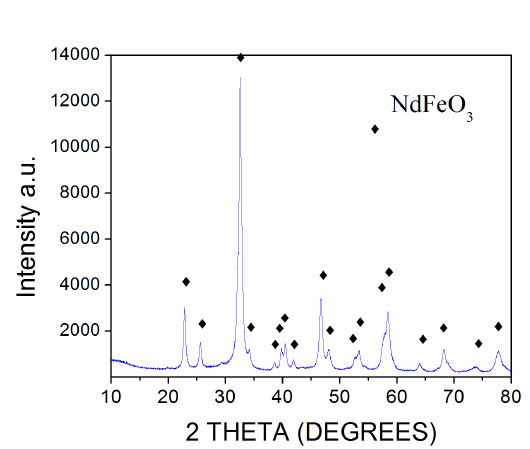
Fig. 3 XRD pattern of powder obtained after 13.5 h of milling from Nd O and Fe O with air 2 3 2 3